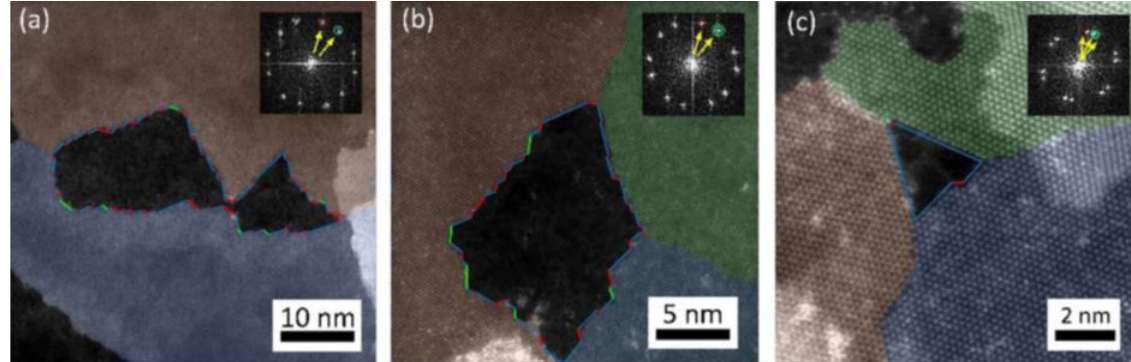
Figure 7. Etching on crystalline edges of the 2H MoS 2 crystals. ( a – c ) ADF-STEM images of etched grain boundaries in as-grown MoS 2 monolayers. The residual edges are marked with blue, red and green lines, representing zigzag (ZZ) Mo edges, ZZ S edges and ZZ S-Mo edges, respectively. Different grains are labelled by different colors, which are also marked with solid circles in the corresponding FFT patterns presented in insets. Reprinted from Reference [70], Copyright (2017), with permission from Elsevier.